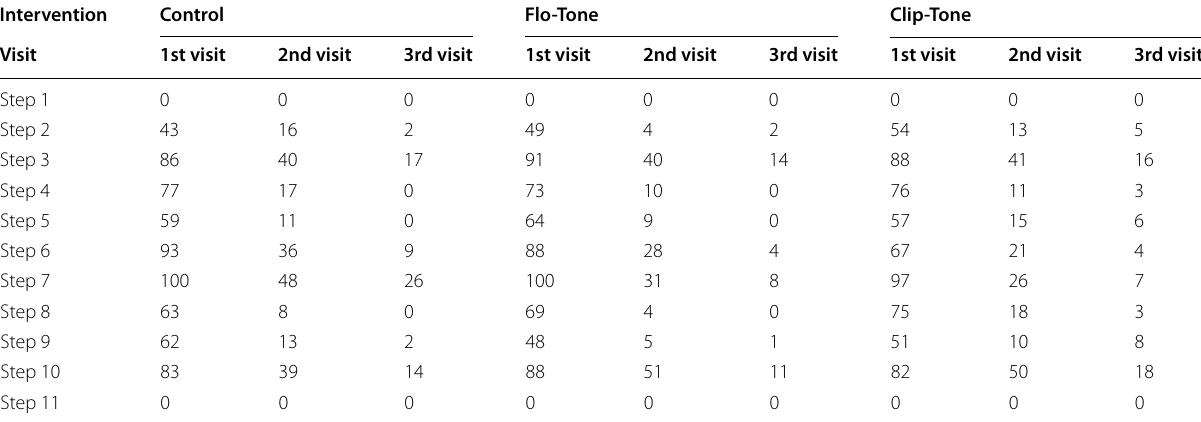
Table 3 Percentage of subjects making mistakes in each inhalation technique step per intervention and visit